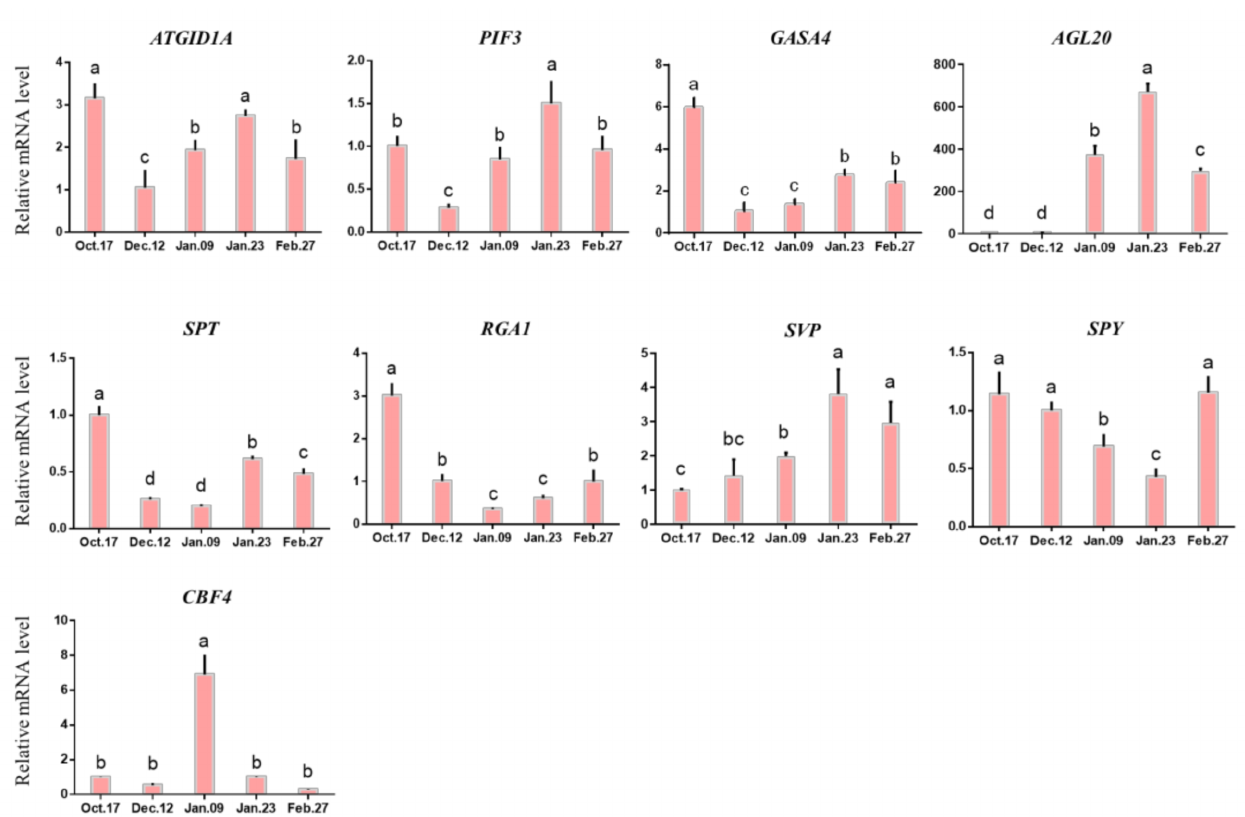
Figure 11. Expression of DAM-SOC1-AP1 pathway and other genes. Each bar represents the mean ± SEM ( n = 3).Different letters indicate a significant difference among different dates ( p < 0.05). The picture was drawn by GraphPad Prism 8.0 and the data were processed by IBM SPSS Statistics